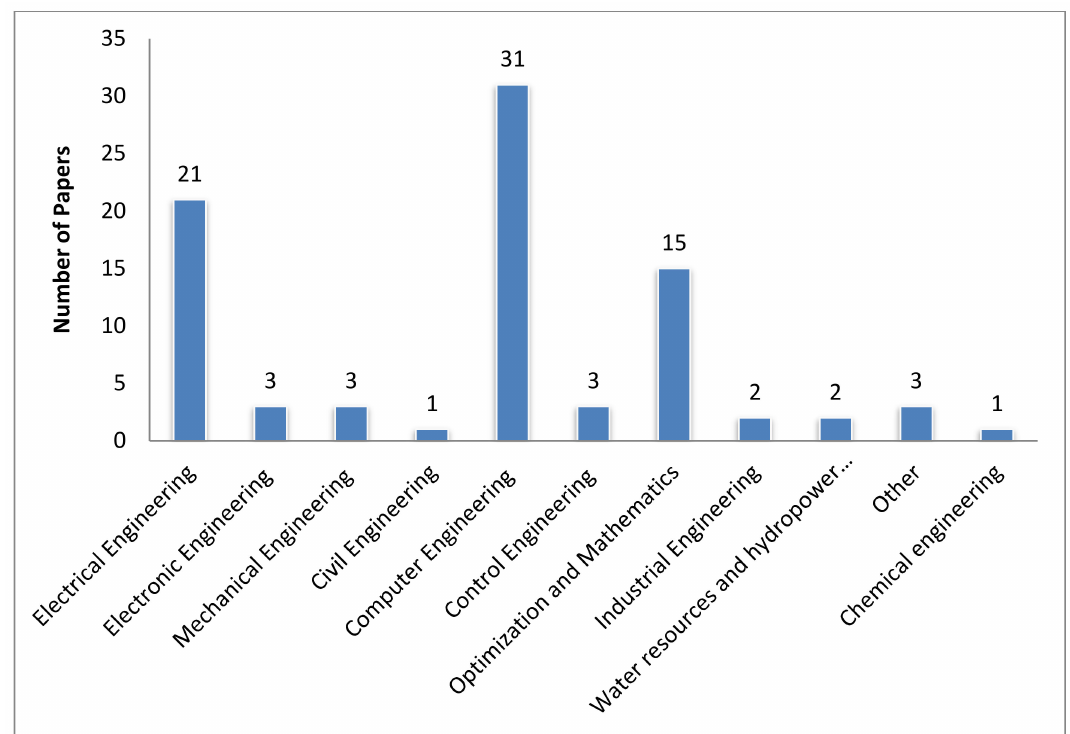
Figure 12. Number of HS-based and fuzzy-related articles published by various research repositories (2012~22 August